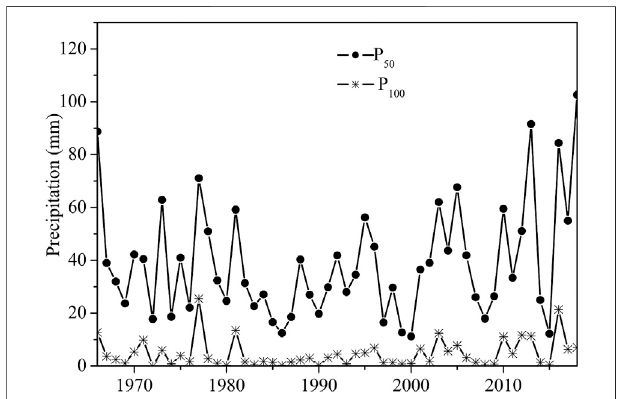
FIGURE 2 | Changes in P 50 and P 100 in the study area from 1966 to